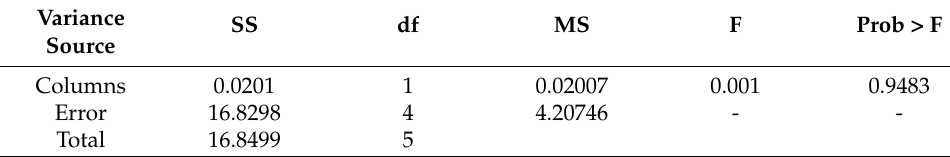
Table 4. ANOVA test on statistical Fourier data based on the selected